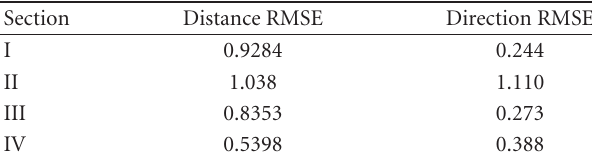
Table 1: RMSE for each